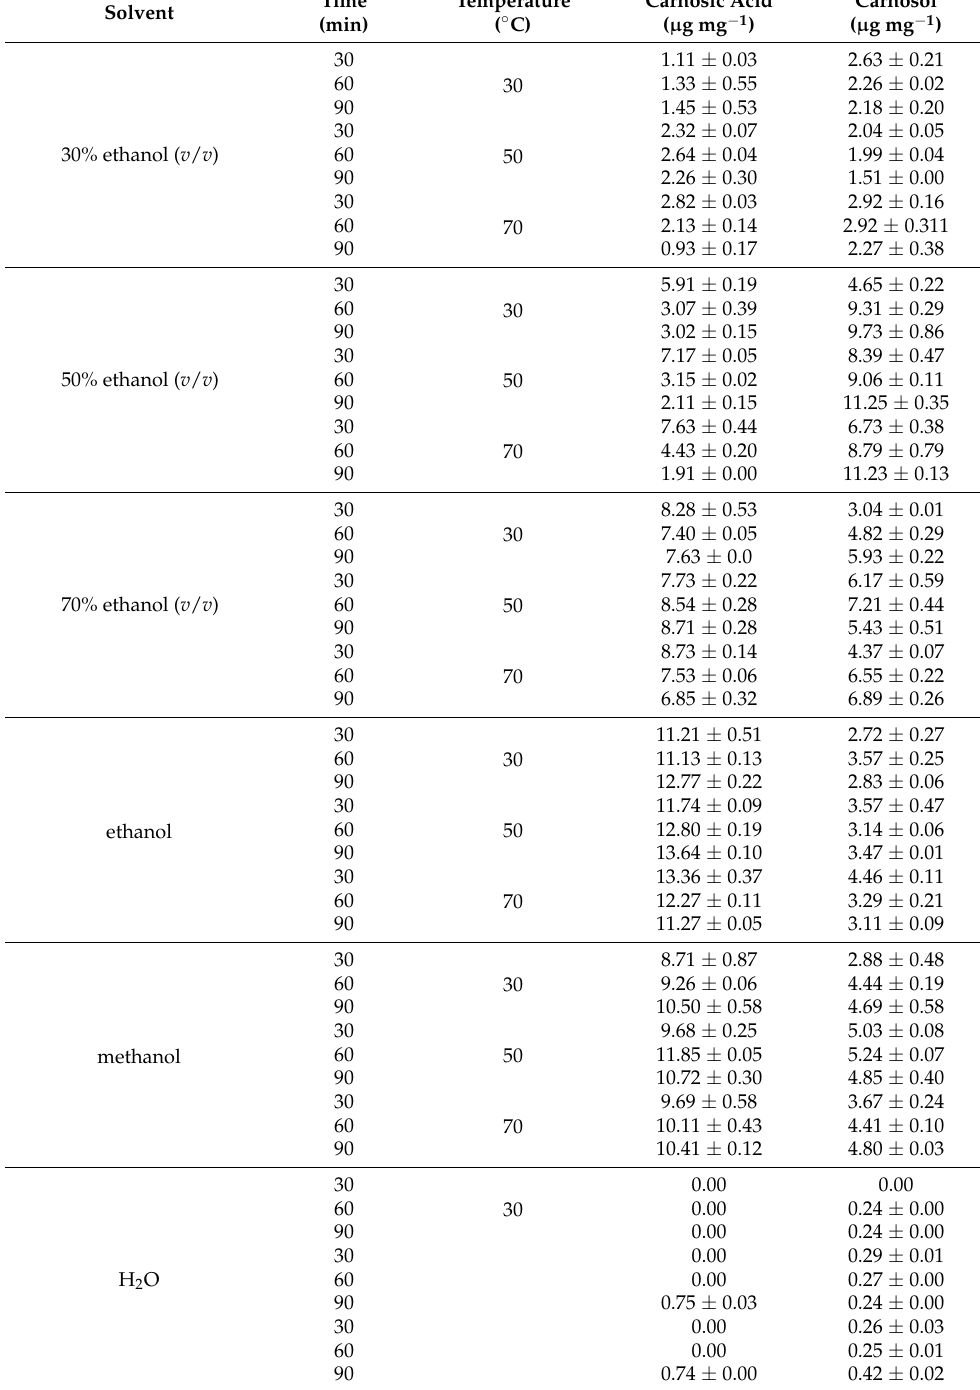
Table 3. The values ( µ g mg − 1 of the plant material) of carnosic acid and carnosol for the extraction obtained by stirring with heating. The results are expressed as mean value ± standard deviation ( n =